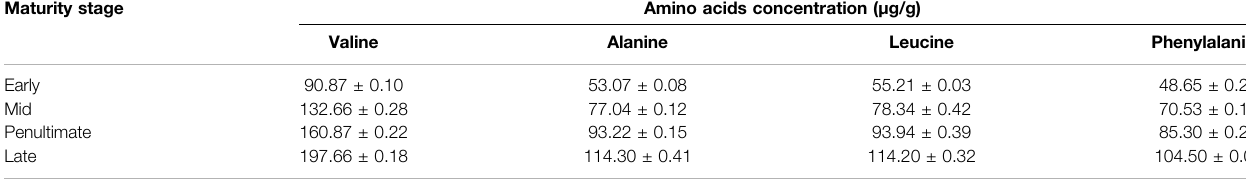
TABLE 4 | Amino acid contents of M. oleifera leaf at different maturity